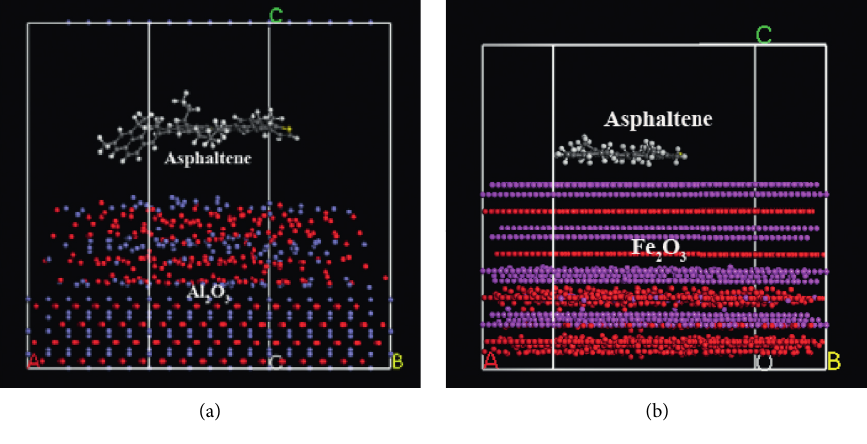
Figure 9: Al 2 O 3 and Fe 2 O 3 adsorbed asphalt. Table 5: Interfacial energy of asphaltene in